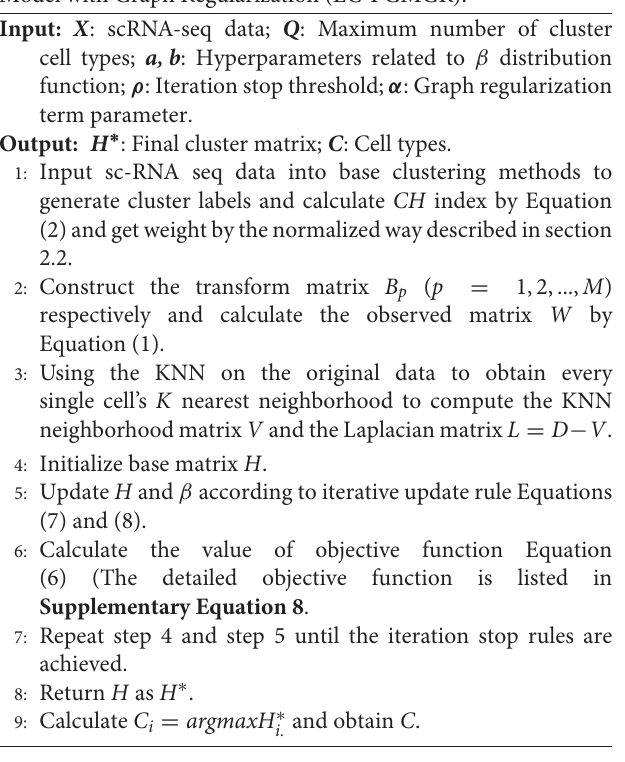
Algorithm 1 | Ensemble Clustering based on Probability Graphic Model with Graph Regularization